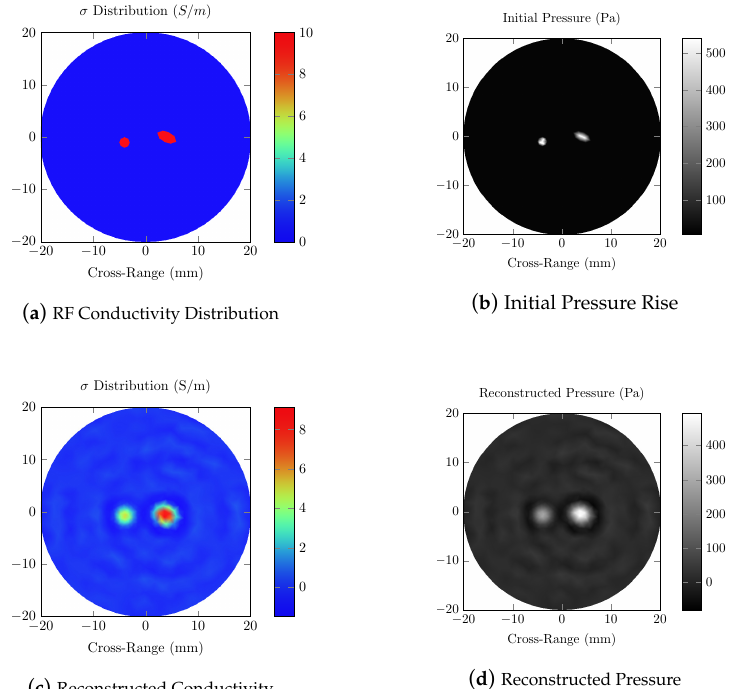
Figure 5. Radio frequency (RF)-induced acoustic computed tomography (RACT) simulations using a 434 MHz RF source on the homogeneous phantom with two absorbers. ( a ) The true RF conductivity distribution; ( b ) the initial pressure rise induced by the thermoacoustic effect; ( d ) the reconstructed pressure, calculated using the time-reversal algorithm; and ( c ) the reconstructed conductivity, obtained by dividing the reconstructed pressure by the electric field